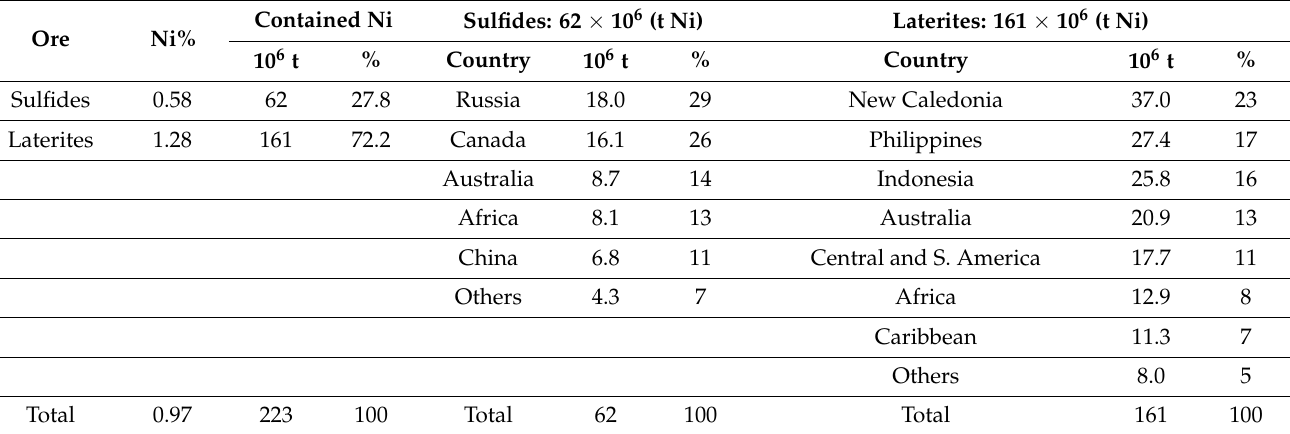
Table 1. World Ni resources, (laterites and sulfides) [1].